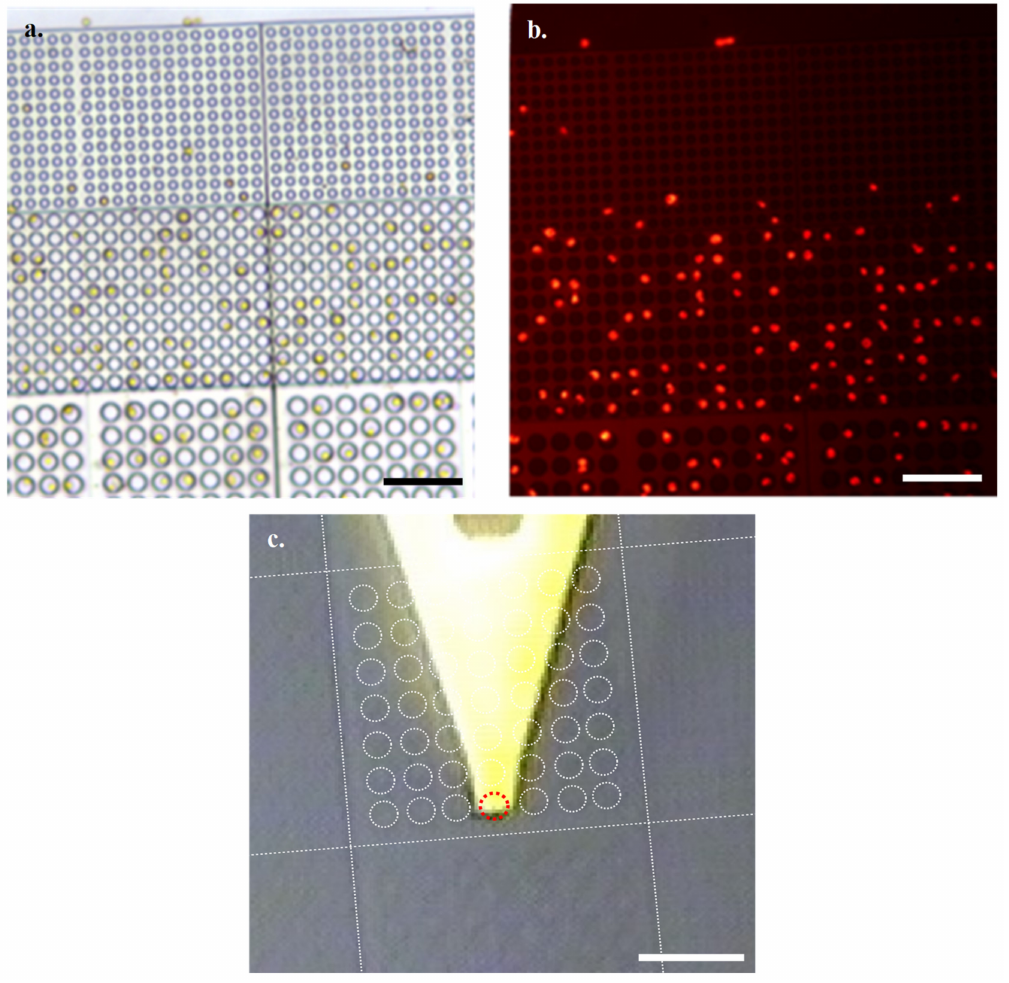
Figure 3. Settled Emiliania Huxleyi ( E. Huxleyi ) cells at × 40 obj by ( a ). optical microscopy and ( b ). fluorescence microscopy (Scale bars 50 µ m) ( c ). In-line HS-AFM optical microscope of array with overlay highlighting arrangement of wells relative to cantilever (Cyl 10 block overlay, Red dashed circle marks the array well directly under the cantilever tip, Scale bar 50 µ